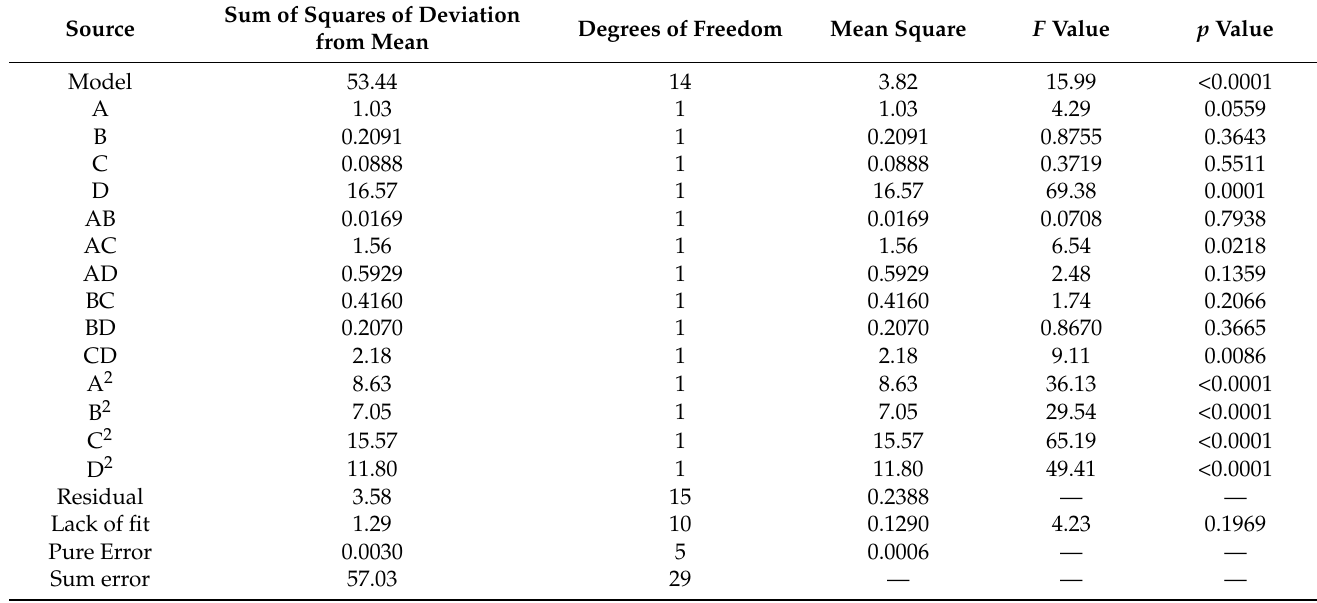
Table 3. Analysis of variance for polyphenols